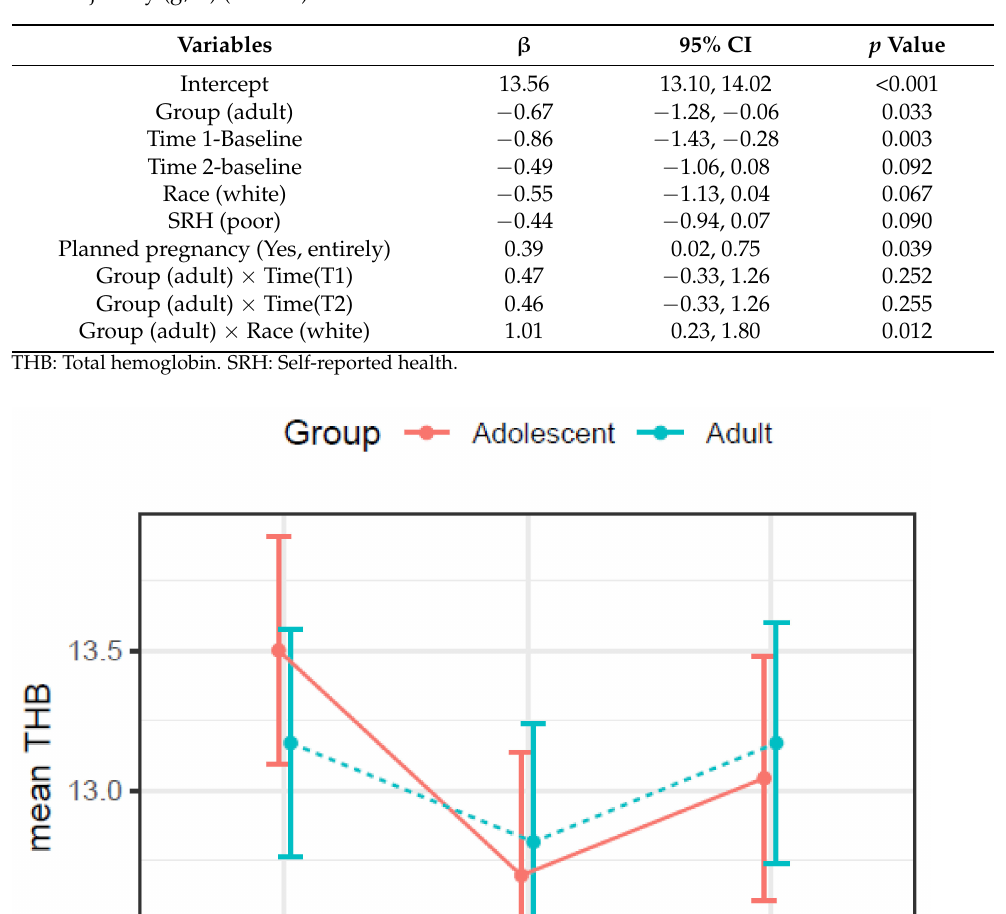
Table 4. Multivariate mixed-effects regression for longitudinal effects of independent variables on THB trajectory (g/L) ( n = 100).